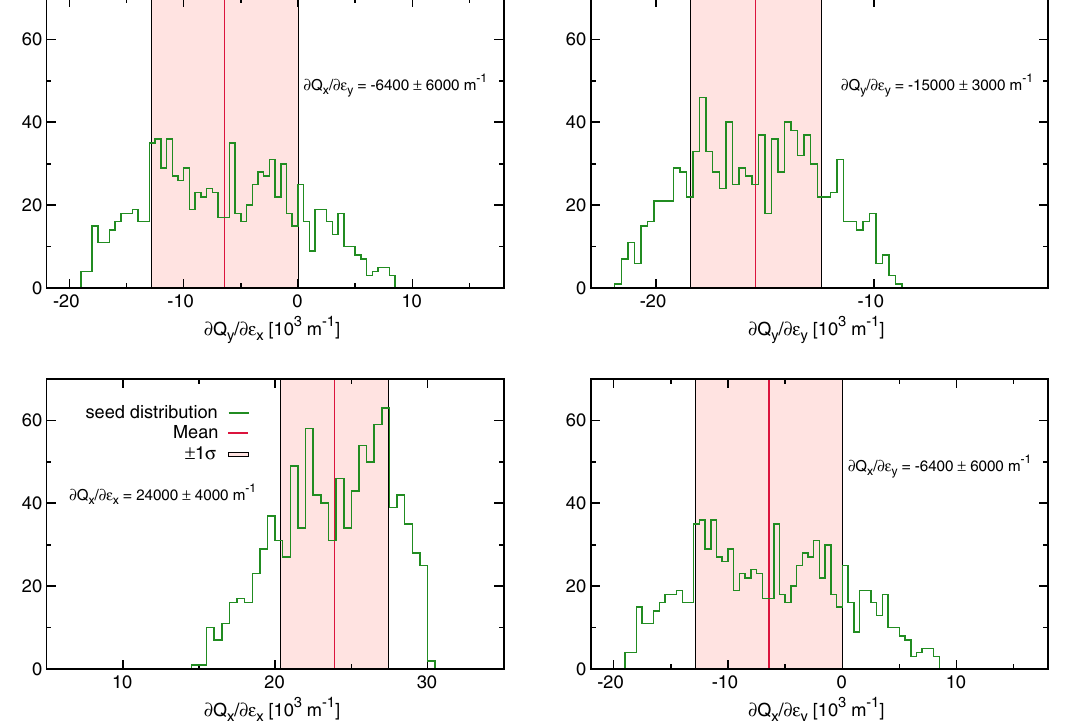
FIG. 9. The distribution of anharmonicities obtained from PTC for 1000 instances of a MAD-X model of the LHC based on our best knowledge of the nonlinear sources and including random distribution of coupling amplitude and phase.